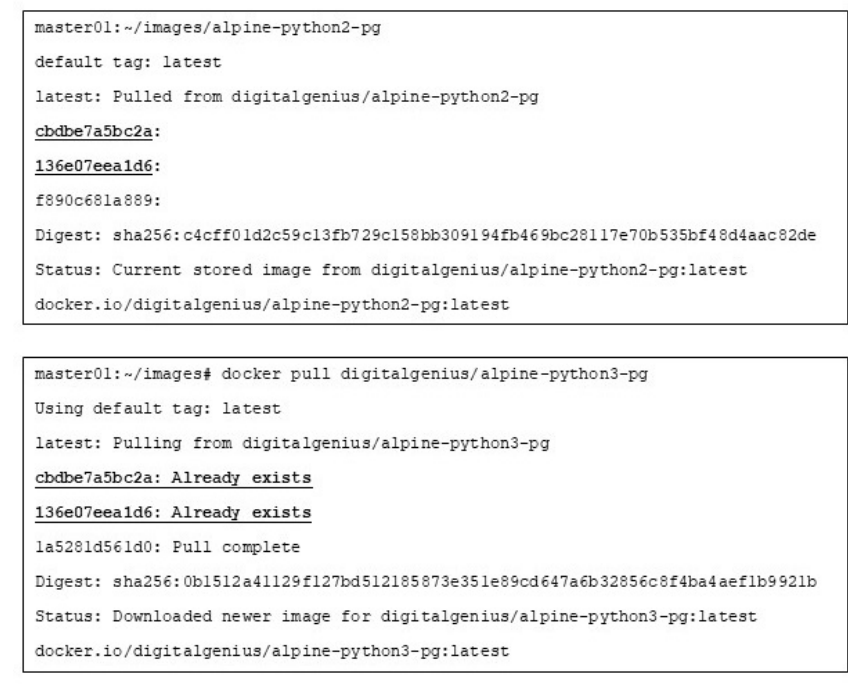
Figure 9. Image Repository Comparison Download.